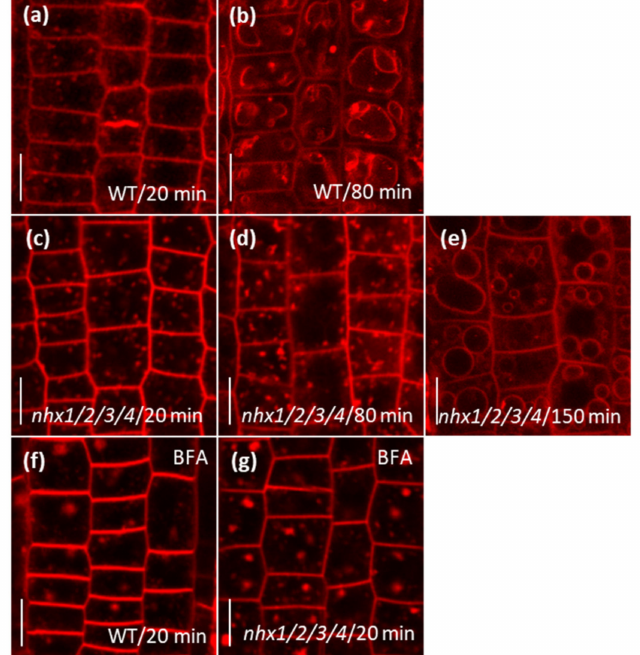
Figure 4. Tra ffi cking to the vacuole is delayed in the nhx1nhx2nhx3nhx4 mutant. ( a , b ), wild type (WT) root tip cells after 20 min ( a ) or 80 min ( b ) after FM4–64 application. ( c – e ), nhx1nhx2nhx3nhx4 ( nhx1 / 2 / 3 / 4) root tip cells after 20 min ( c ), 80 min ( d ) or 150 min ( e ) after FM4–64 application. ( f , g ), formation of BFA bodies in the root tip cells of the WT ( f ) or nhx1nhx2nhx3nhx4 mutant ( g ). Scale bars, 10 µ